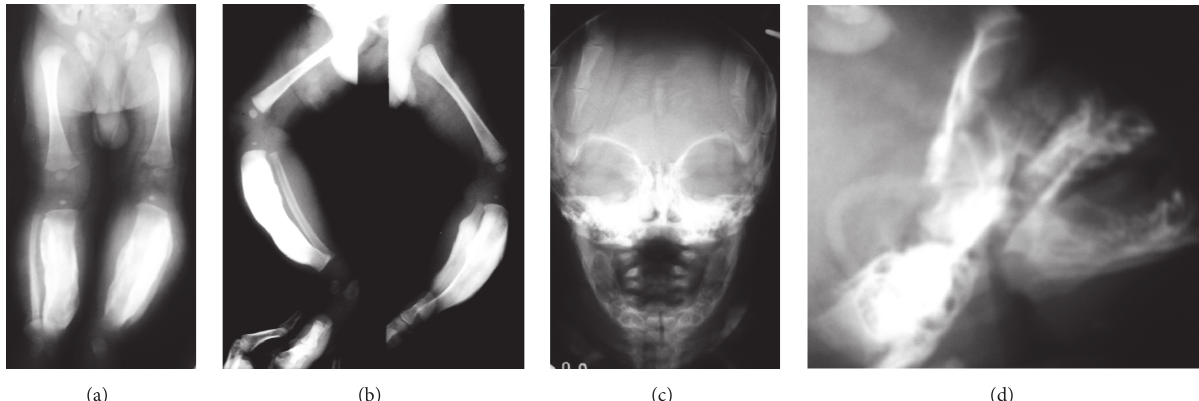
Figure 2: Radiographs of the cortical hyperostosis. ((a) and (b)) Massive cortical thickening and bowing of both tibias are shown. Thickening of left fibula is observed. Soft parts of both legs are thickened in frontal and lateral view. ((c) and (d)) Massive external cortical of mandible in frontal and lateral projection. Mandible is swollen.